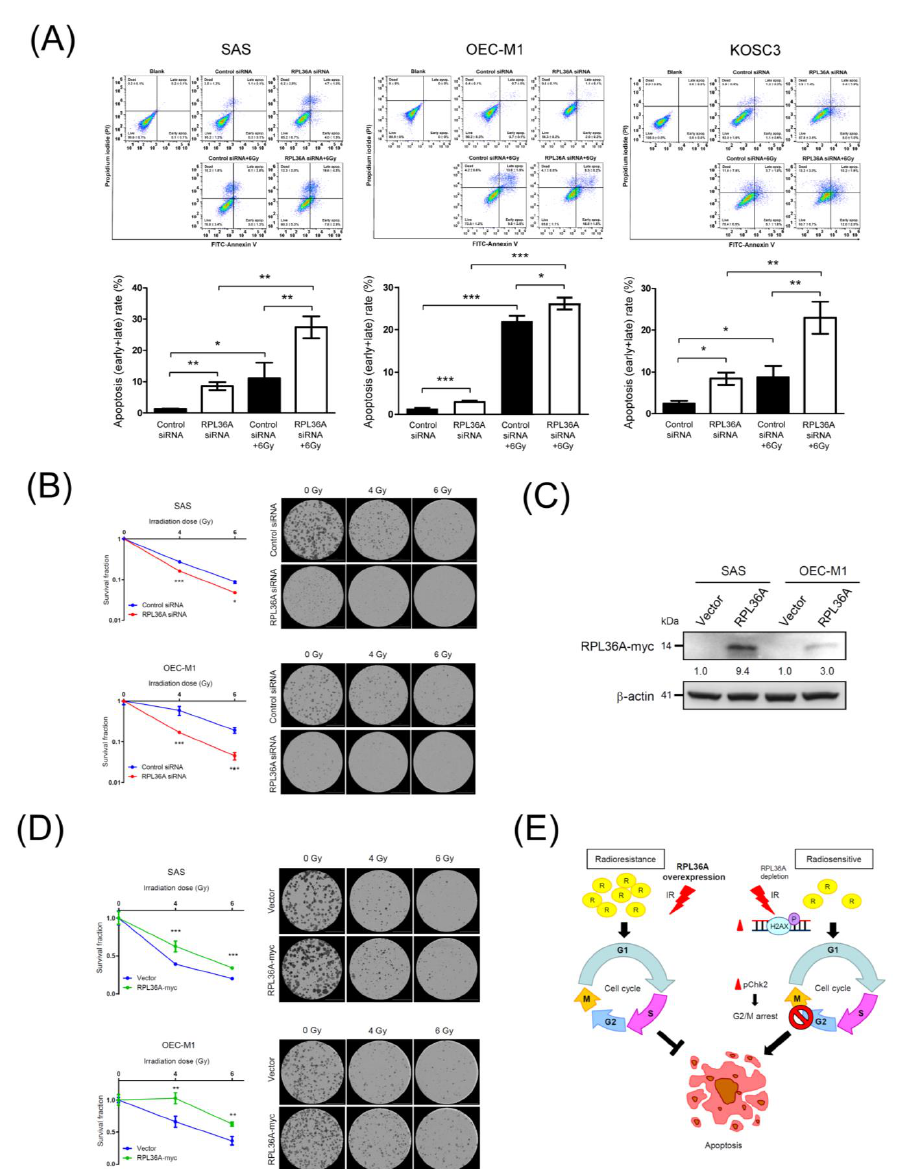
Figure 5. RPL36A depletion augments apoptosis in response to irradiation: ( A ) SAS, OEC-M1, and KOSC3 cells were transfected with control siRNA and RPL36A-specific siRNA. After 6 Gy irradiation of SAS cells for 72 h, OEC-M1 cells for